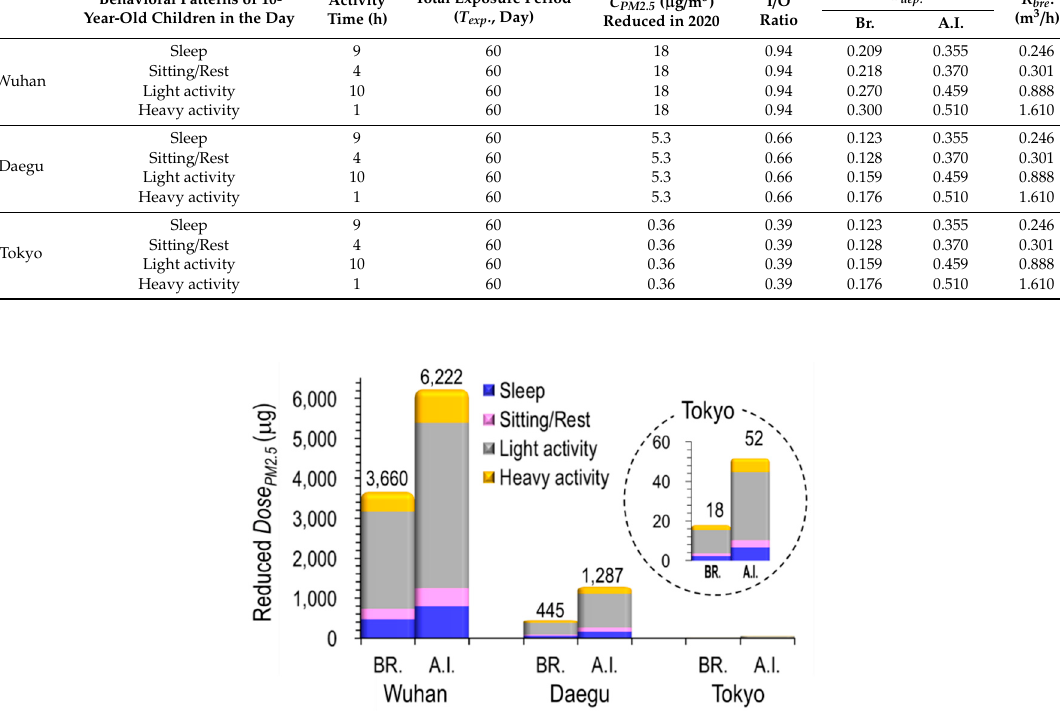
Figure 8. The reduced Dose PM 2.5 10 -year-old children ( µ g) at bronchiolar and alveolar-interstitial (AI) region over two months after the self-reflection of each city.